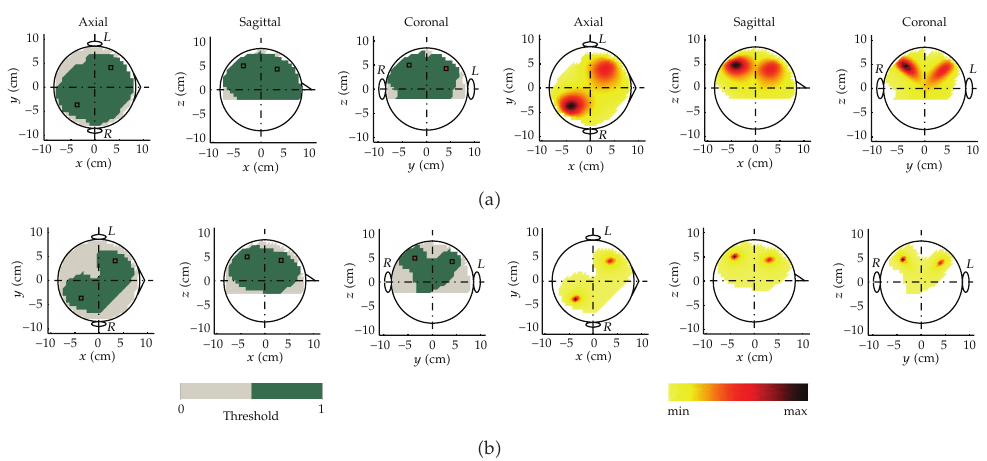
Figure 4: Reduced scanning regions (cid:2) left (cid:3) by our proposed beamformer and reconstructed images (cid:2) right (cid:3) over simulated data with di ff erent SNRs. (cid:2) a (cid:3) SNR: 0.1. (cid:2) b (cid:3) SNR: